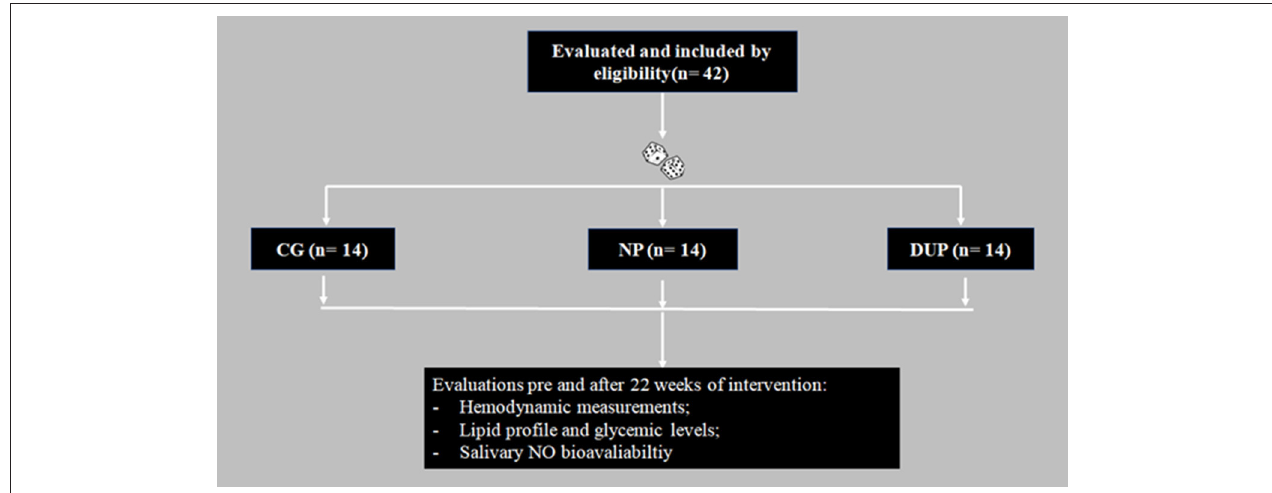
FIGURE 1 | Flowchart of the study . NP, Non-periodized; DUP, Daily undulating periodization; CG, Control group; NO, Nitric oxide.